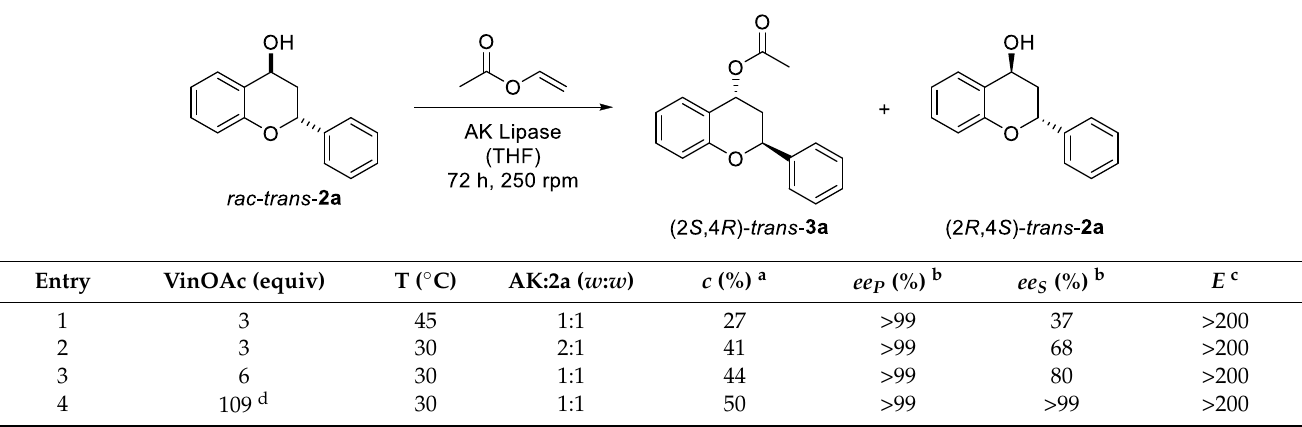
Catalysts 2021 , 11 , x FOR PEER REVIEW